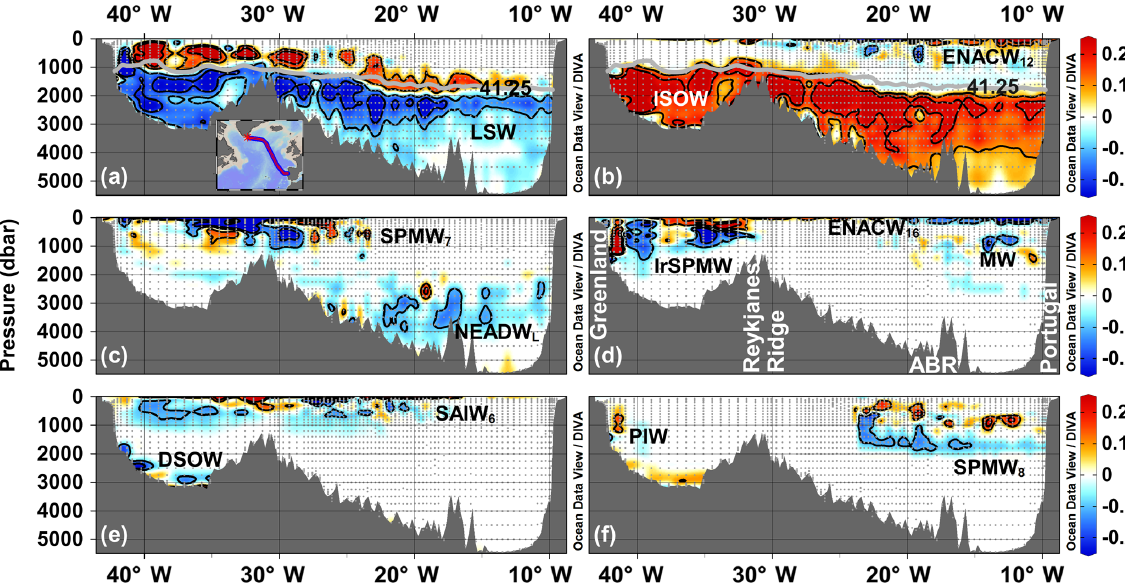
Figure 6. Water mass differences between the OVIDE line (inset in subplot a ) in 2014 and the average of 2002–2010, from Portugal (right) to Greenland (left). Positive (negative) anomalies in the proportion of a water mass imply a gain (loss) in 2014 compared to 2002–2010. The grey line in subplots (a) and (b) represents the isopycnal σ 3 = 41.25gm − 3 discussed in the text. The changes in SAIW 4 are not shown due to its low representation along the section. Sample locations appear as grey dots. ABR refers to Azores–Biscay Rise. Consult Table 1 for water mass